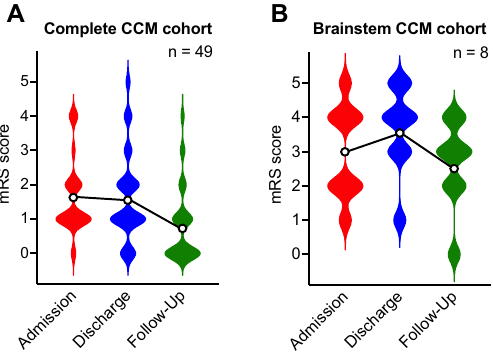
Figure 1. Illustration of longitudinal mRS scores preoperatively at admission, postoperatively at discharge and postoperatively at last follow-up examination. Data is presented as violin plots. Circles indicate mean